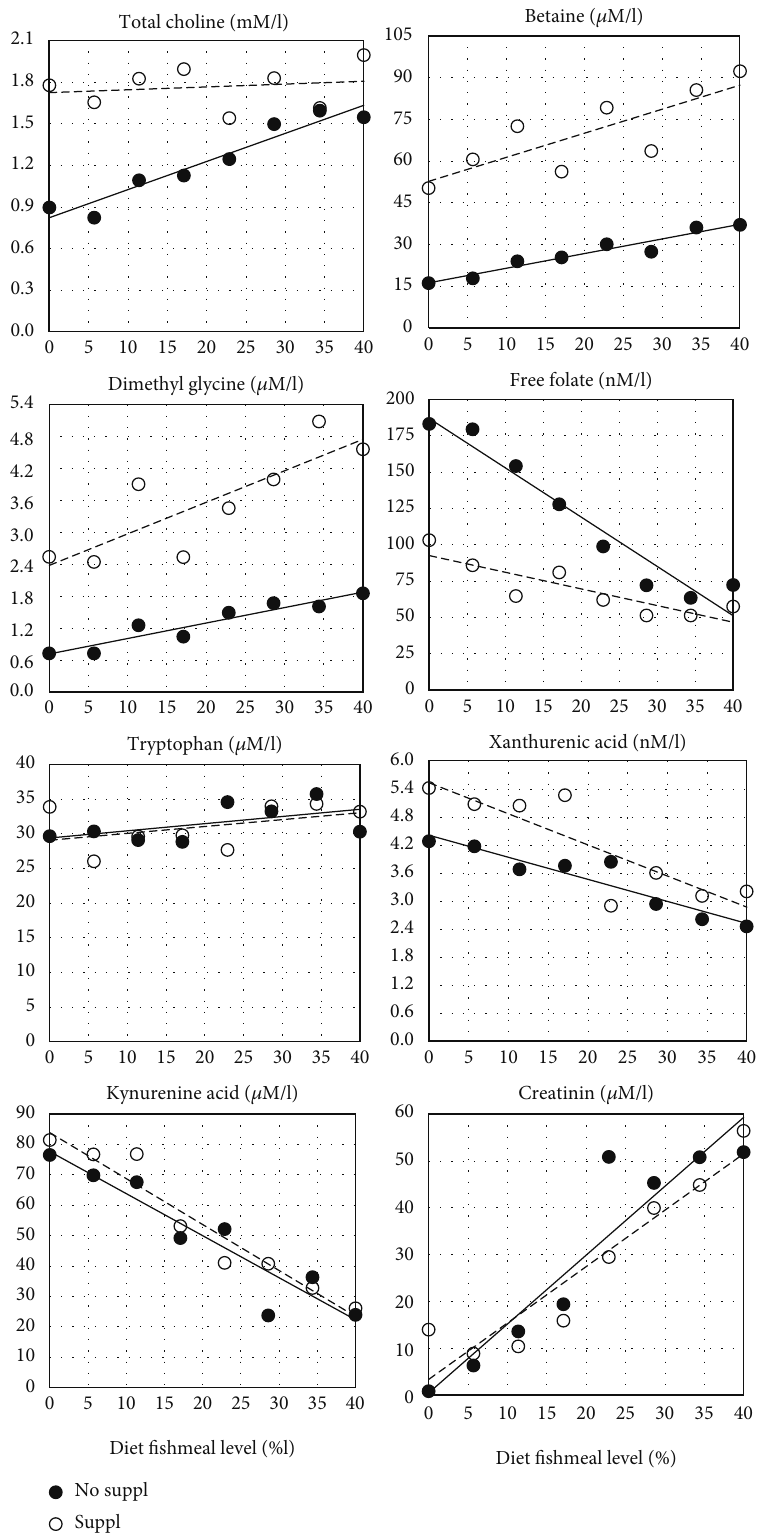
Figure 9: E ff ects of increasing dietary level of fi shmeal given without (No suppl) and with (Suppl) a mixture of 0.3% choline chloride, 0.05% β -glucan and 0.05% nucleotides (Suppl) on plasma levels of biomarkers current for the present study and with an important relationship with choline metabolism and